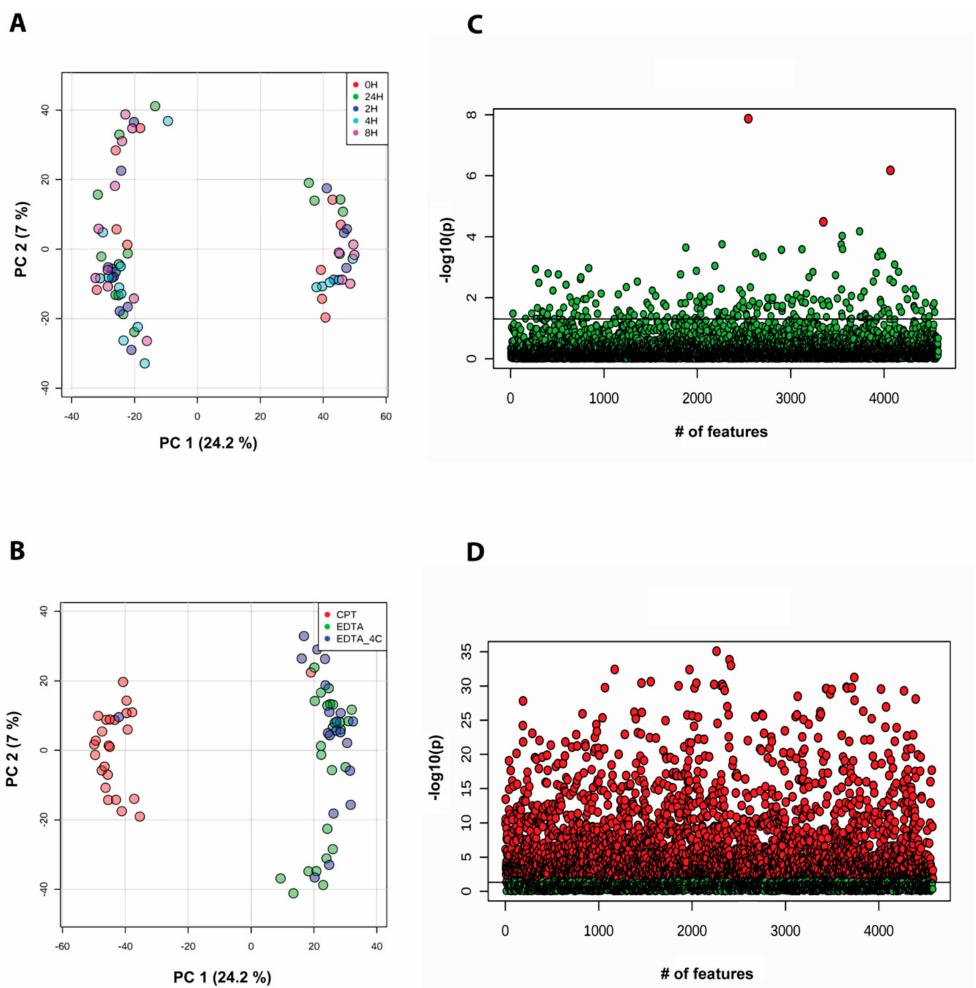
Figure 6. Principal component analysis in donor-unmatched samples from metabolomics data acquired in positive ionization mode. Samples are grouped by ( A ) storage time and ( B ) anticoagulants used. Analysis of variance with Fisher’s LSD test at adjusted p-value at 0.05 grouped by ( C ) storage time and ( D ) anticoagulants (red dots show p -value < 0.05). Note: The Y -axis scale of scatter plot is automatically adjusted by Metaboanalyst based on the range of − log10(p). The line on the scatter plot demarcates the − log10(0.05) value on Y